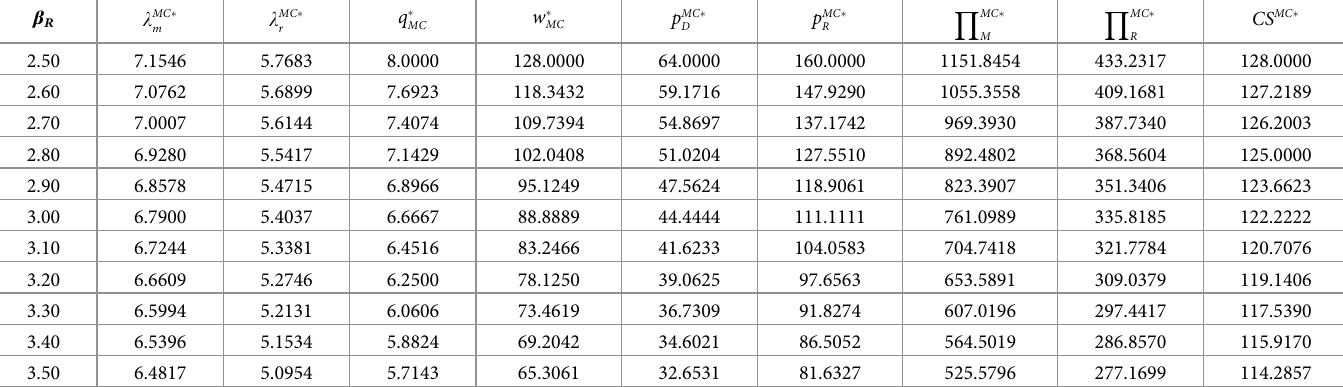
Table 3. In the mixed channel scenario ( ε =